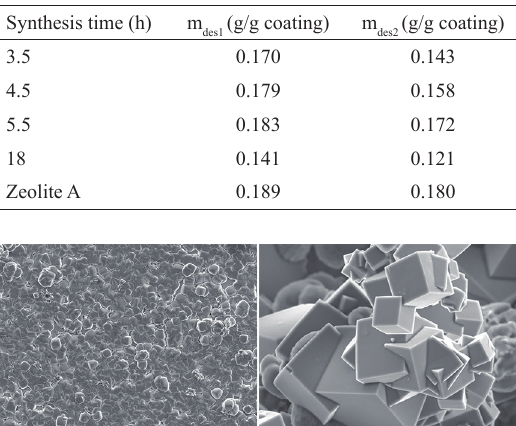
and m denote the first and des1 des2